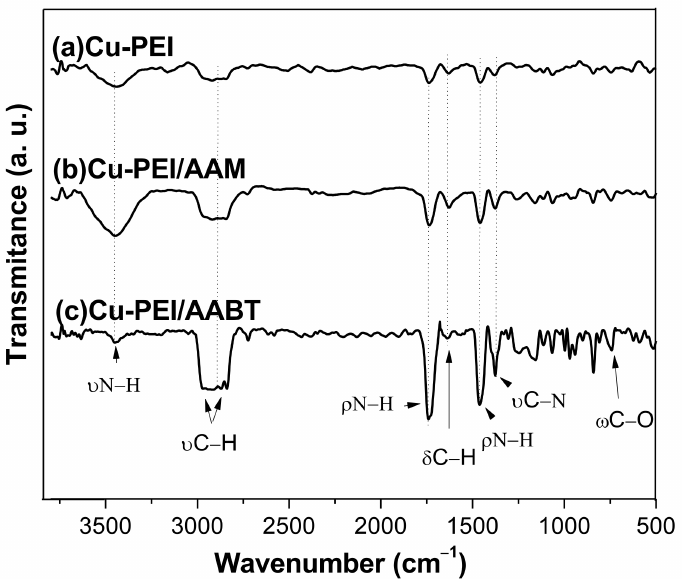
Figure 6. FTIR spectra of the Cu NPs with different stabilizers, ( a ) Cu-PEI; ( b ) Cu-PEI/AAM; ( c )